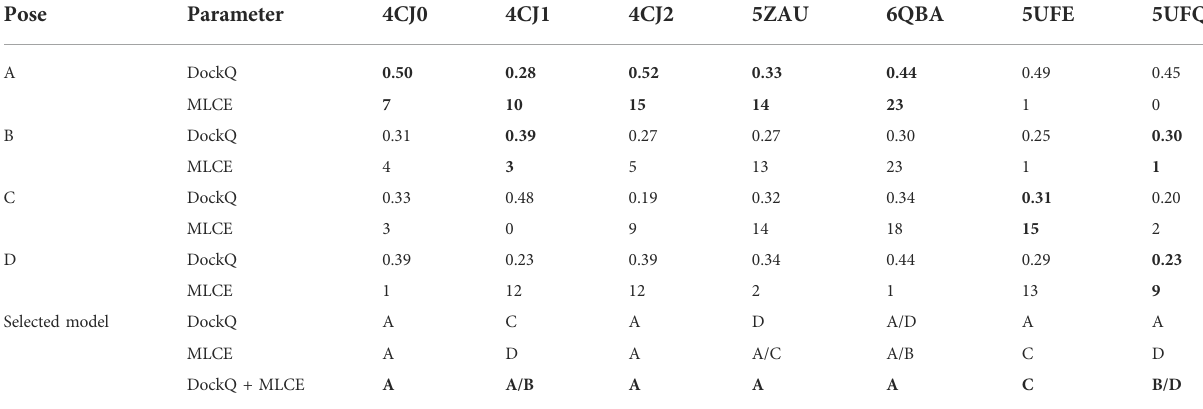
TABLE 4 Selection of the models on the basis of DockQ and MLCE results.